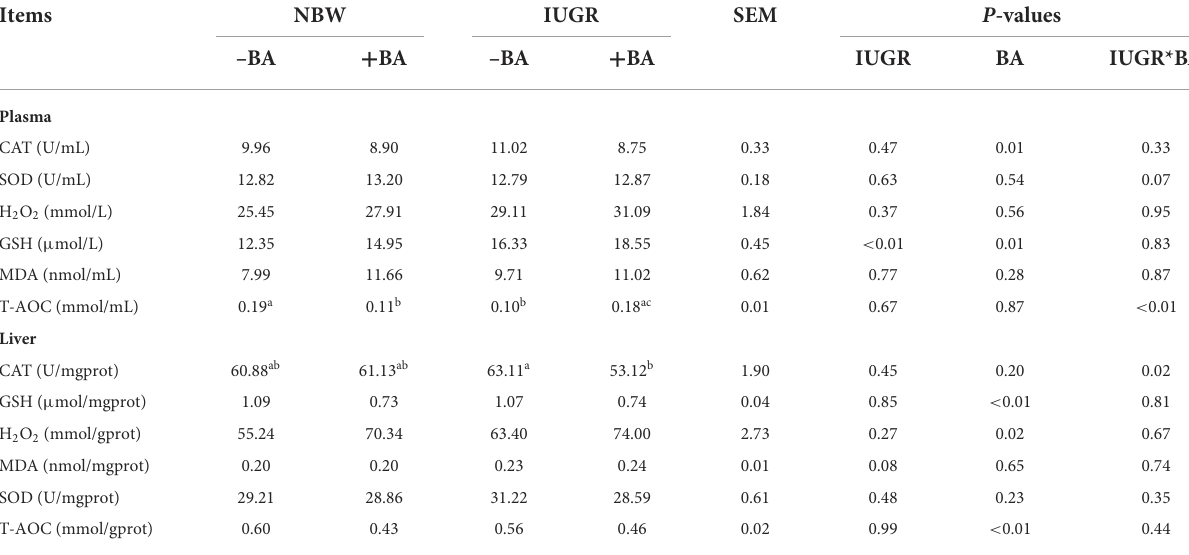
TABLE 5 Effects of dietary bile acid (BA) supplementation on plasma and liver oxidant/antioxidant indices in weaned piglets with NBW and IUGR. Items